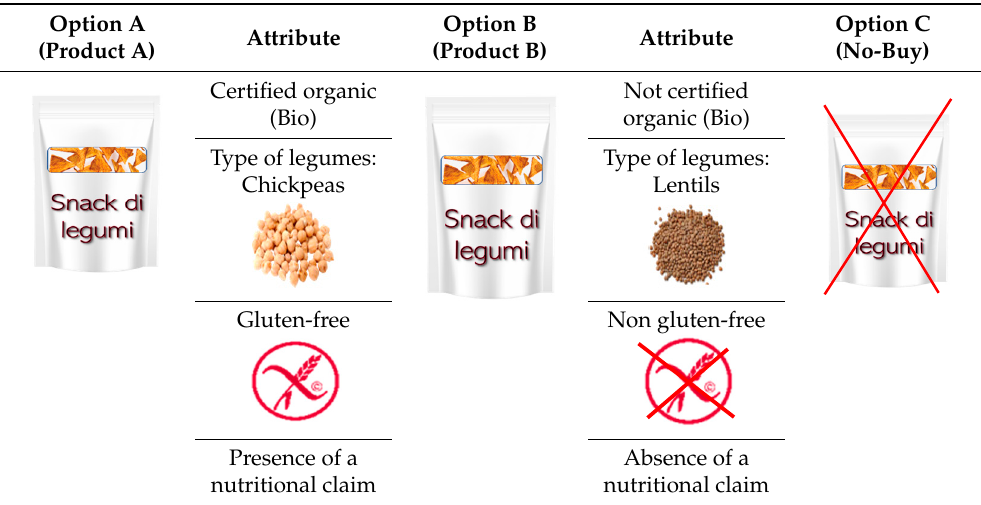
Table 2. An example of a choice set used in our discrete choice experiment.